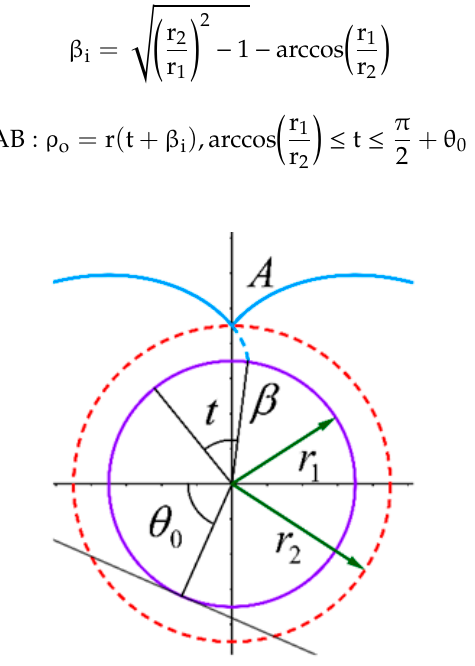
Figure 11. Displacement of the absorber of the involute cusp.